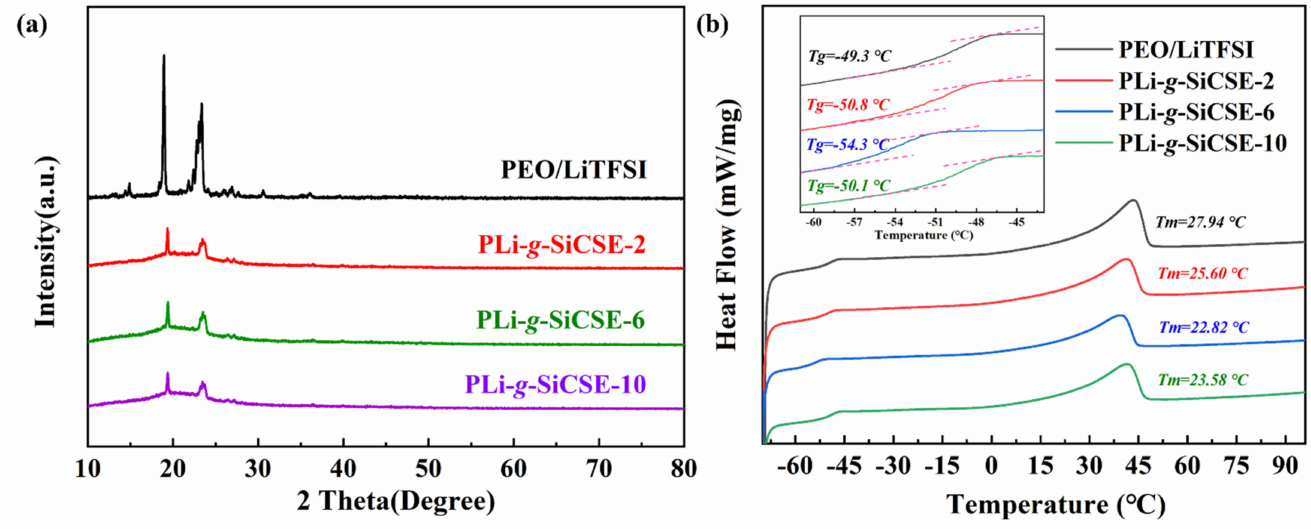
Figure 5. ( a ) XRD patterns and ( b ) DSC of the prepared CSEs containing PEO/LiTFSI and different amounts of PLiSSPSI- g -SiO 2